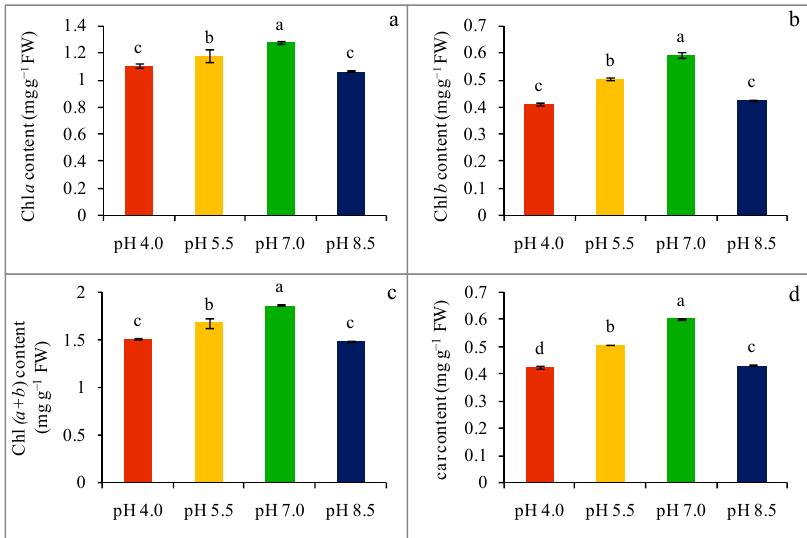
Figure 3. Chlorophyll a ( a ), chl b ( b ), total chl (a + b) ( c ), and car ( d ) contents of wheat leaves under different levels of pH. Mean (±SD) was computed from three replications of each treatment. Bars with dissimilar letters are significantly different at p ≤ 0.05 from Fisher’s LSD test.